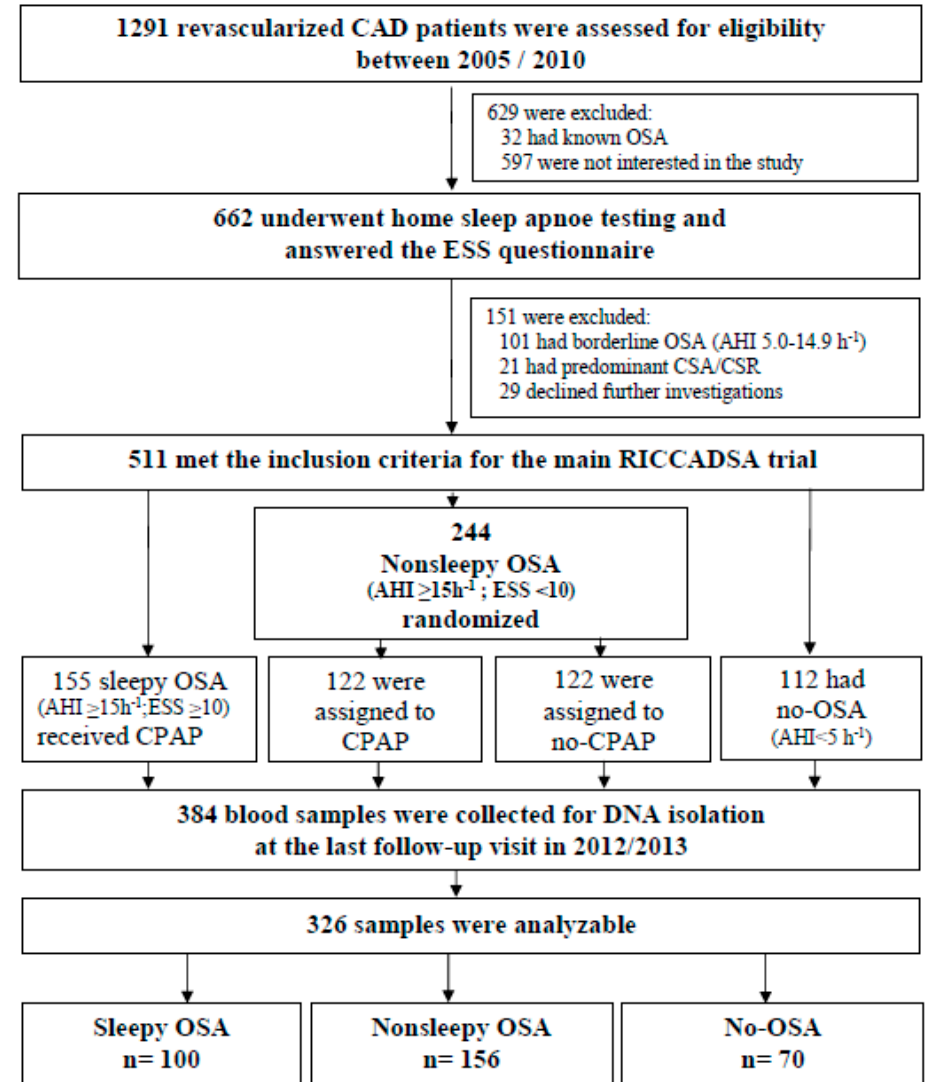
Figure 1. Flow of patients through the study. Abbreviations: AHI, apnea–hypopnea index; CAD; coronary artery disease; CPAP, continuous positive airway pressure; CSA-CSR, central sleep apnea– Cheyne Stokes respiration; ESS, Epworth Sleepiness Scale; OSA, obstructive sleep apnea; RICCADSA, Randomized Intervention with CPAP in Coronary Artery Disease and Sleep